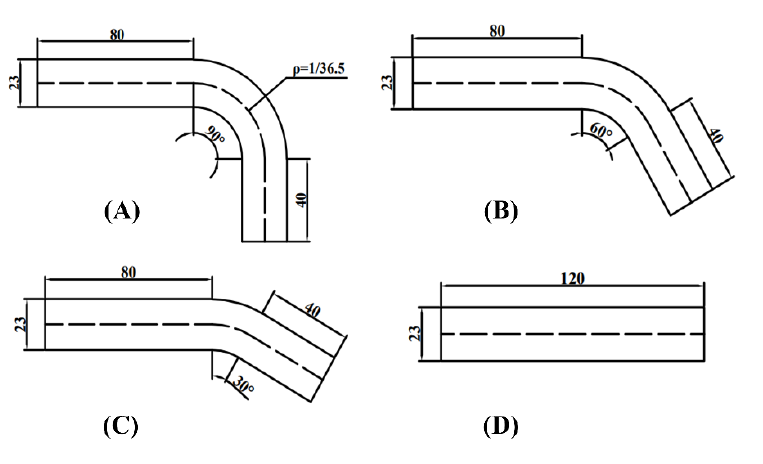
Figure 7. Parameters of river channels; ( A ) 90° river channel; ( B ) 120° river channel; ( C ) 150° river channel; ( D ) 180° river channel.